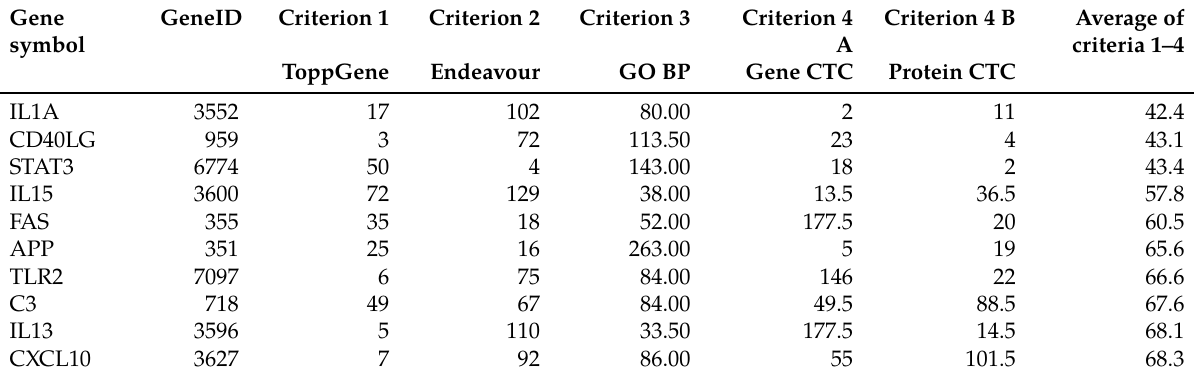
Table 1: Top 10 of the most significant genes.